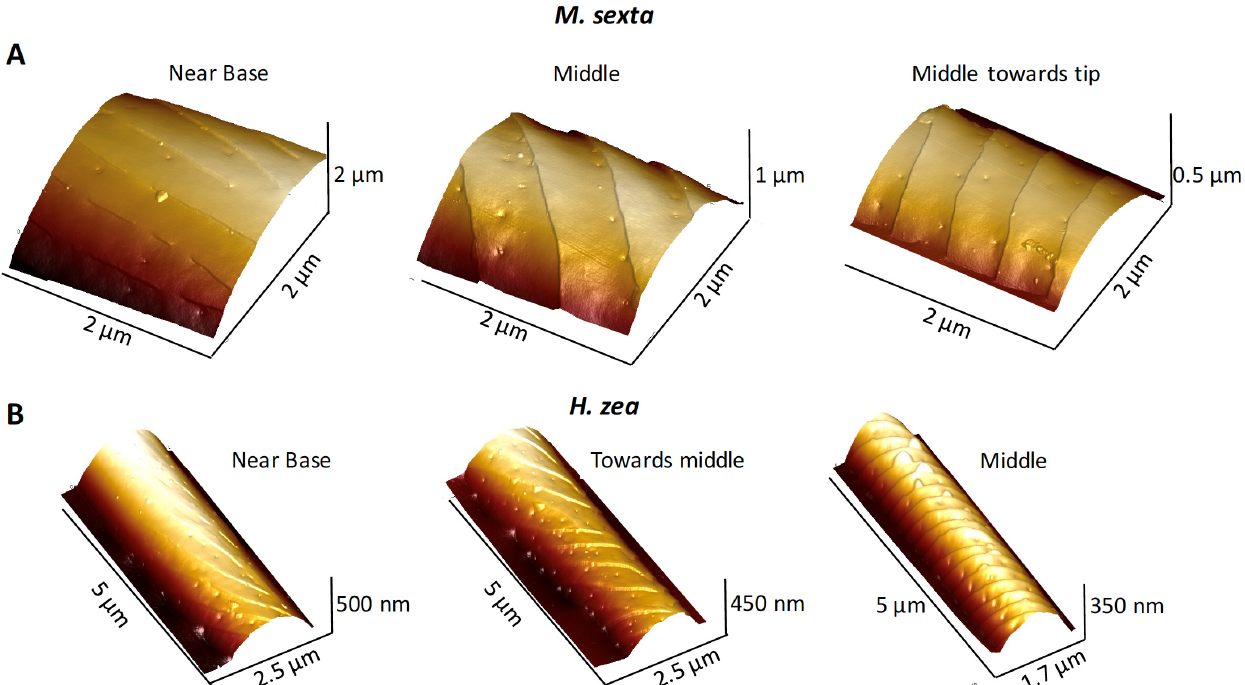
Figure 5. Illustration of how sensillar ridges are oriented more longitudinally with respect to the longitudinal axis of a sensillum near its base to become oriented more transversely more distally toward the tip of the sensillum. ( A ) Three AFM 3D images of a single Manduca sexta trichoid sensillum taken successively from near its base (left) to an area more distally toward its tip. ( B ) Three AFM 3D images of a single Helicoverpa zea trichoid sensillum taken successively from near its base to an area more distally toward its